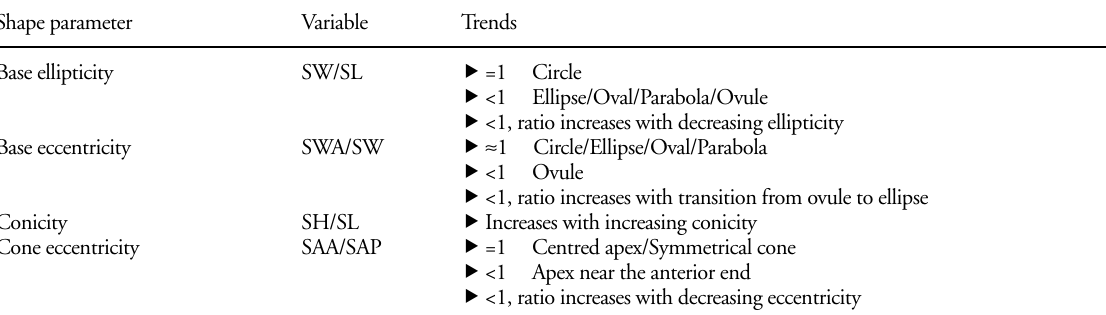
Table 1. Variables used in the analyses of shell